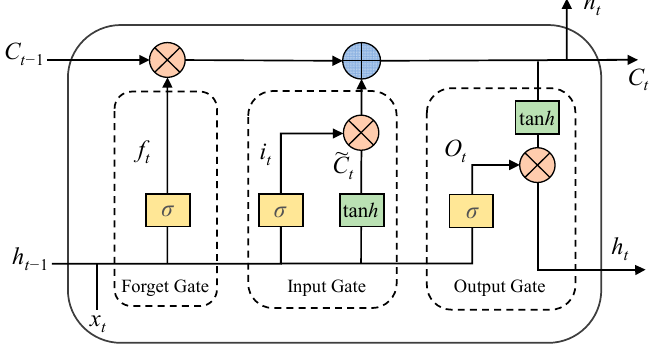
Figure 2. The basic structure of LSTM.